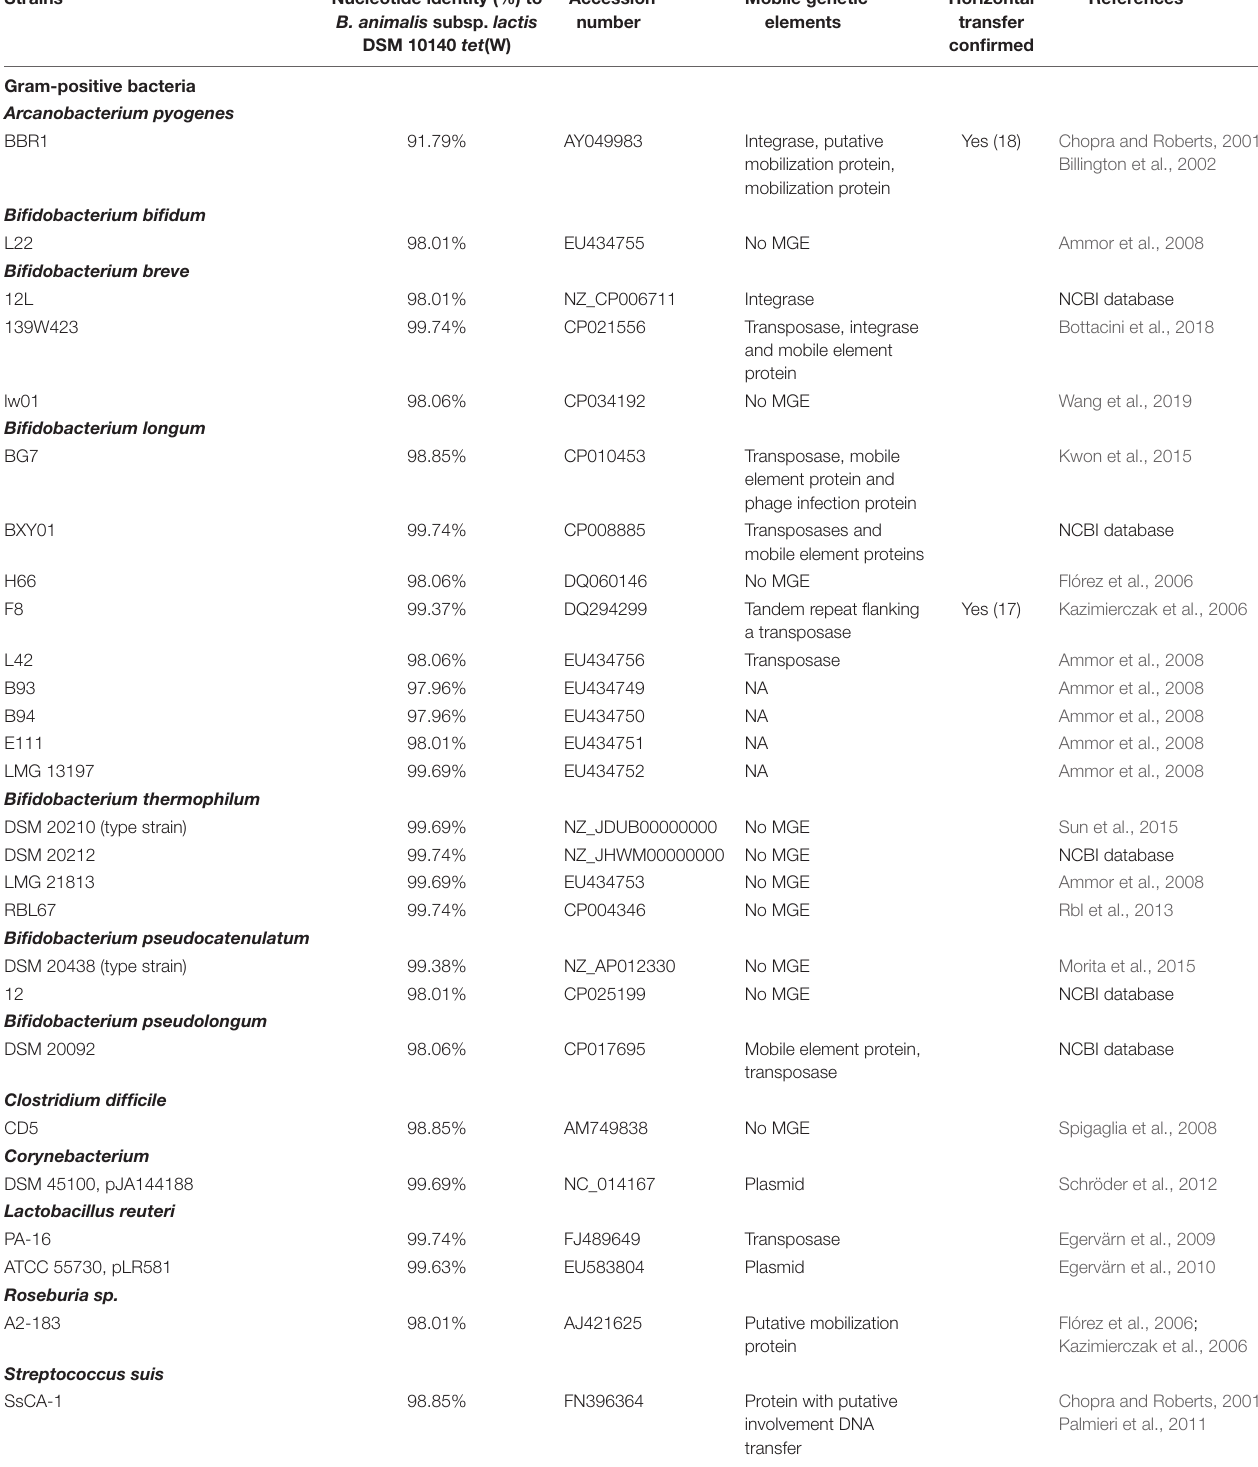
TABLE 1 | tet (W) encoded by Gram-positive and Gram-negative bacteria. Strains Nucleotide identity (%) to B. animalis subsp.